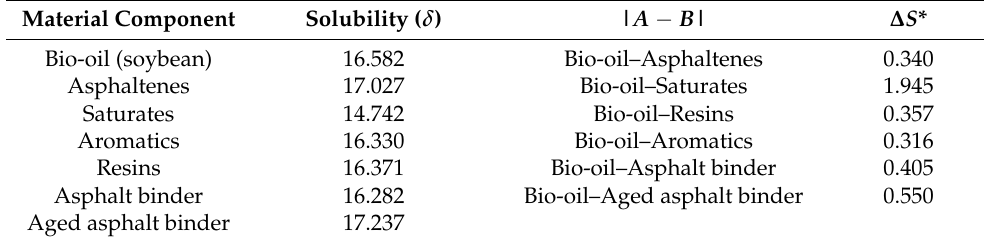
Table 7. Solubility parameter ( δ )